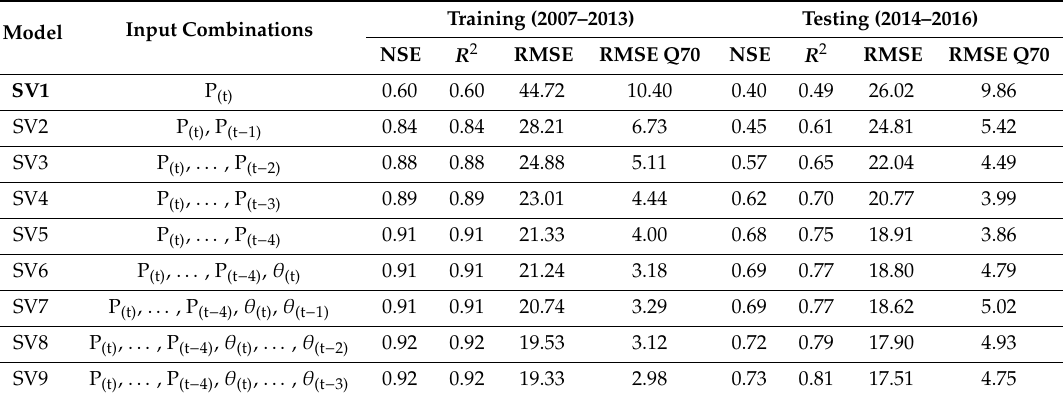
Table 3. Model performance measures with di ff erent combinations of lagged input variables during the training and testing